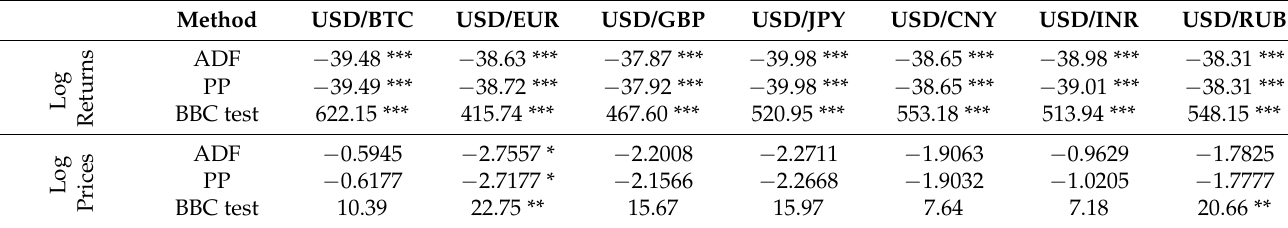
Table 2. Unit Root